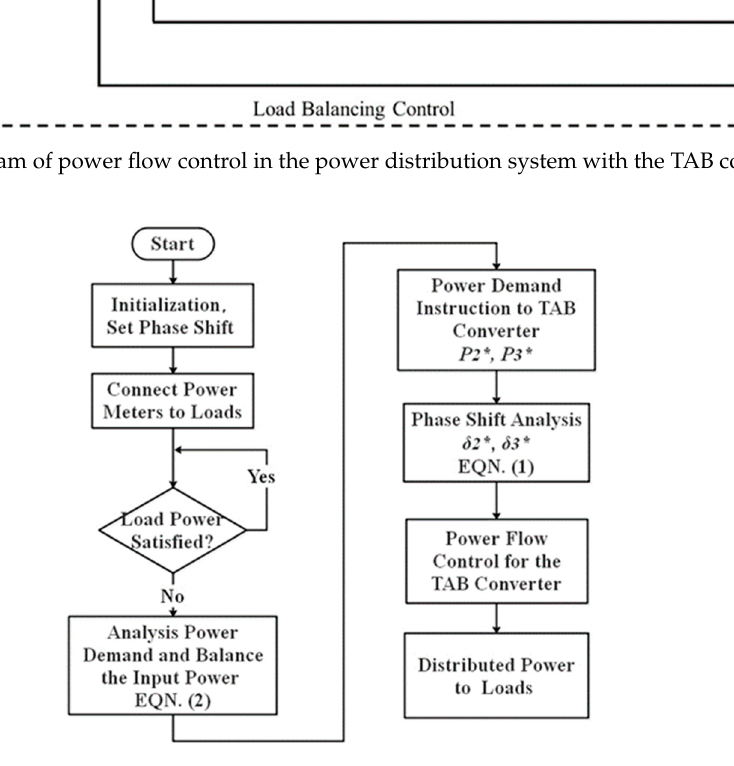
Figure 5. Diagram of power flow control in the power distribution system with the TAB converter.